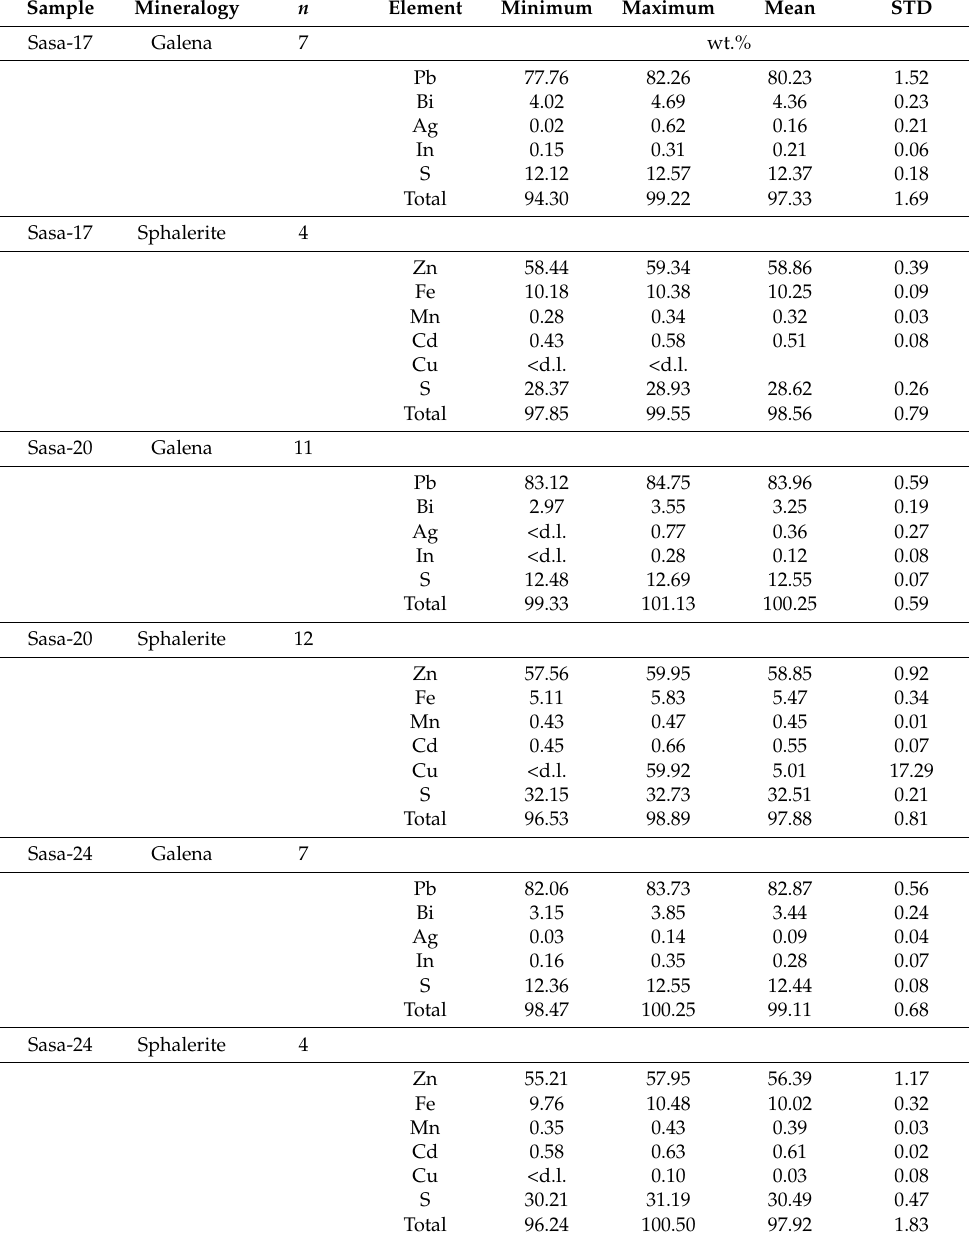
Table 2. Semi-quantitative composition of sulfides from the Sasa Pb-Zn-Ag skarn deposit. n —number of point analyses per sample; <d.l.—below detection limit; STD—standard deviation.